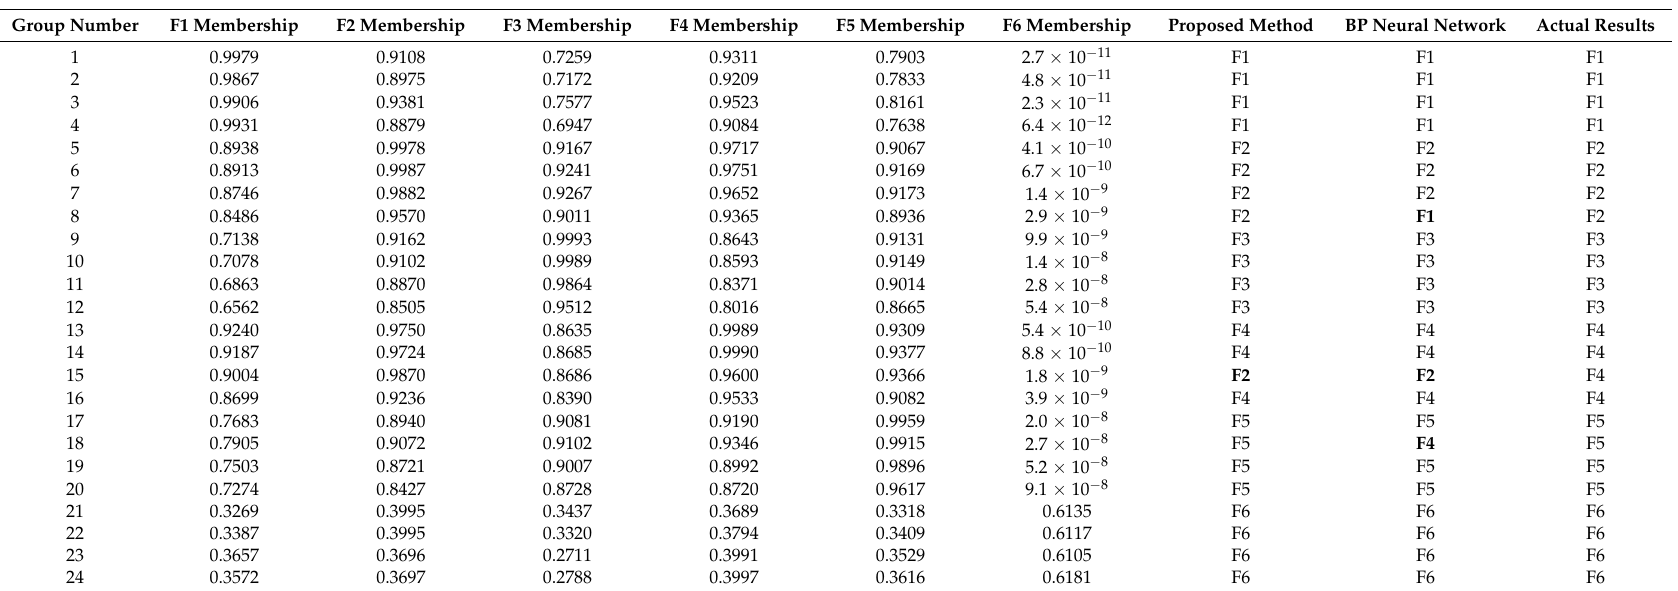
Table 8. The comparison results of different fault diagnosis methods for testing